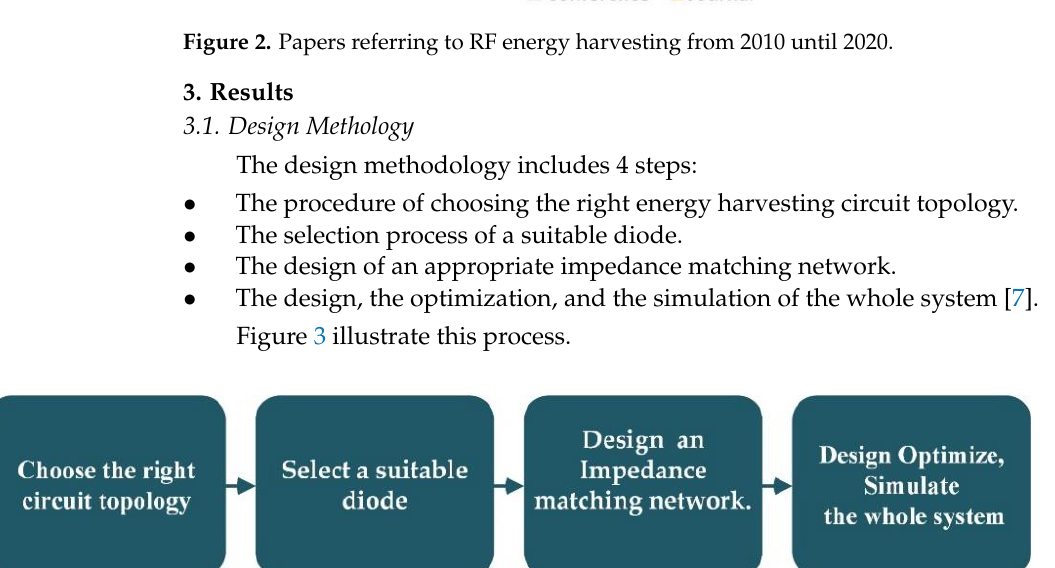
Figure 2. Papers referring to RF energy harvesting from 2010 until 2020.